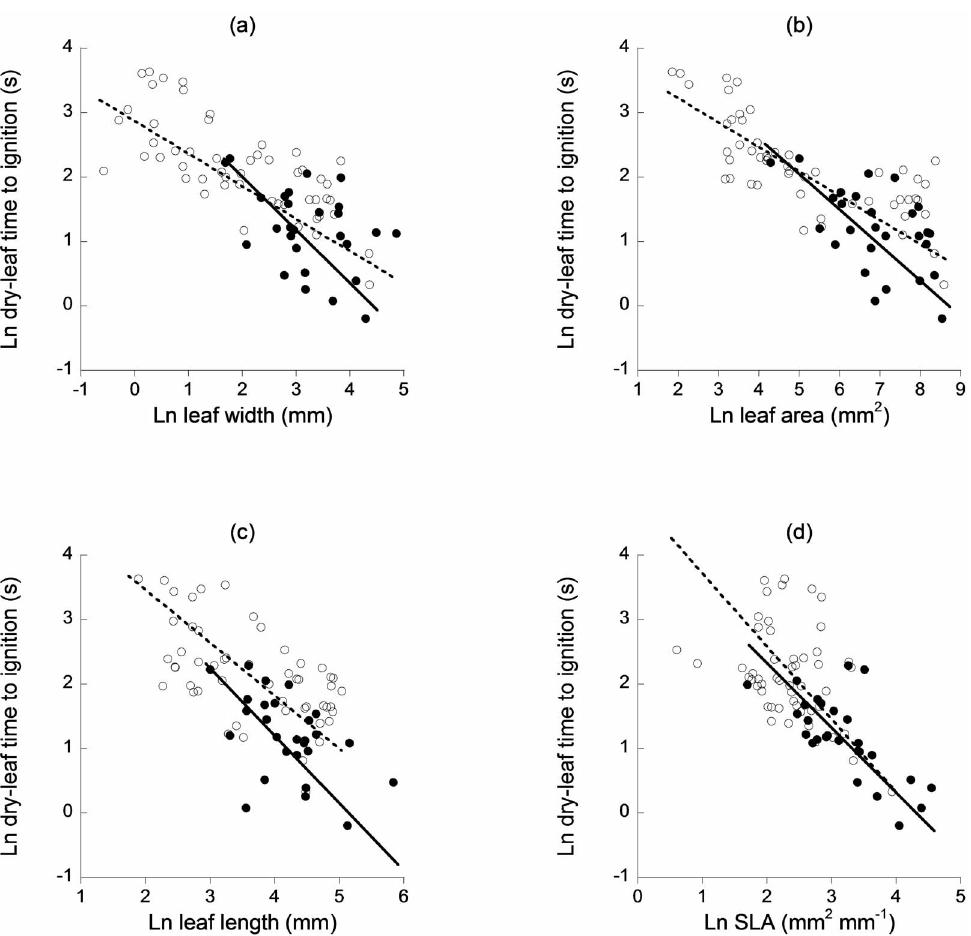
Figure 3. Scaling relationships between fresh-leaf flammability and (a) leaf width, (b) leaf area, (c) leaf length and (d) specific leaf area. Native species are represented by open circles and dashed lines and exotic species by closed triangles and solid lines.